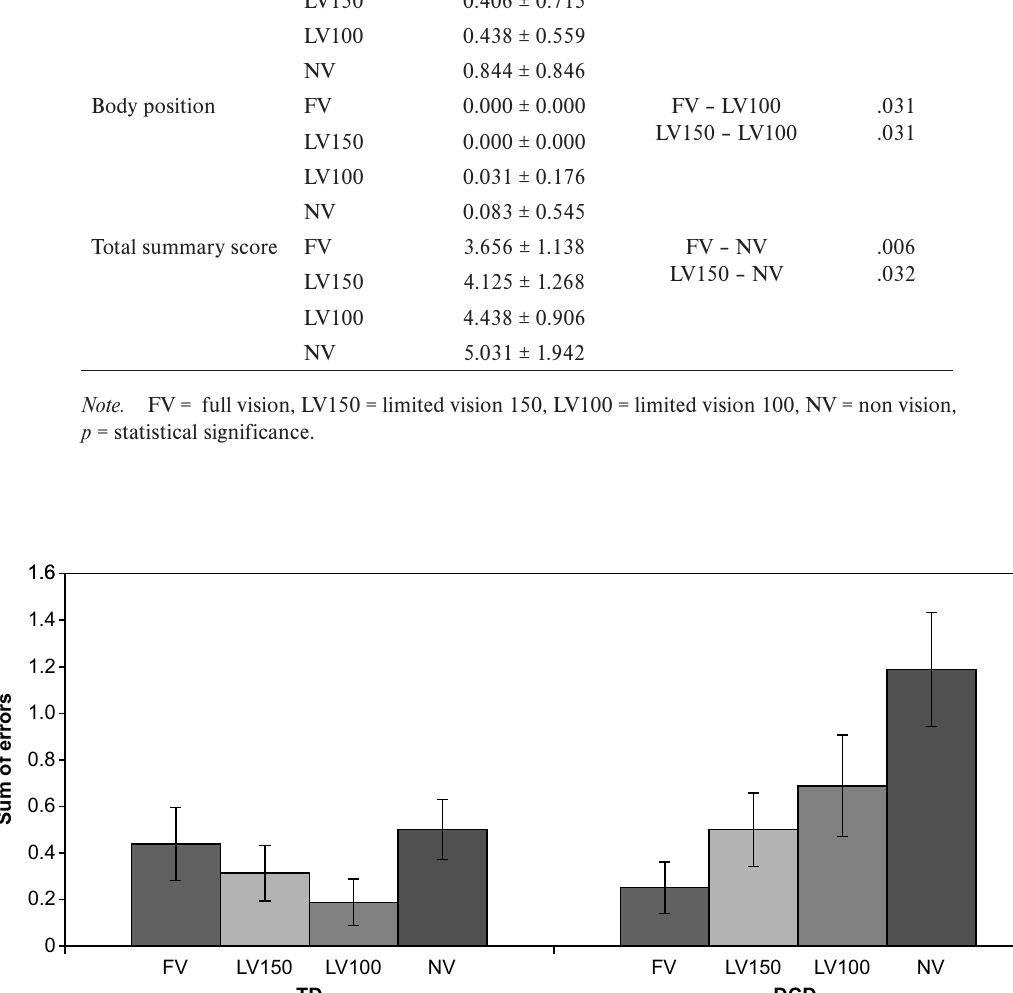
= risk of developmental coordination r